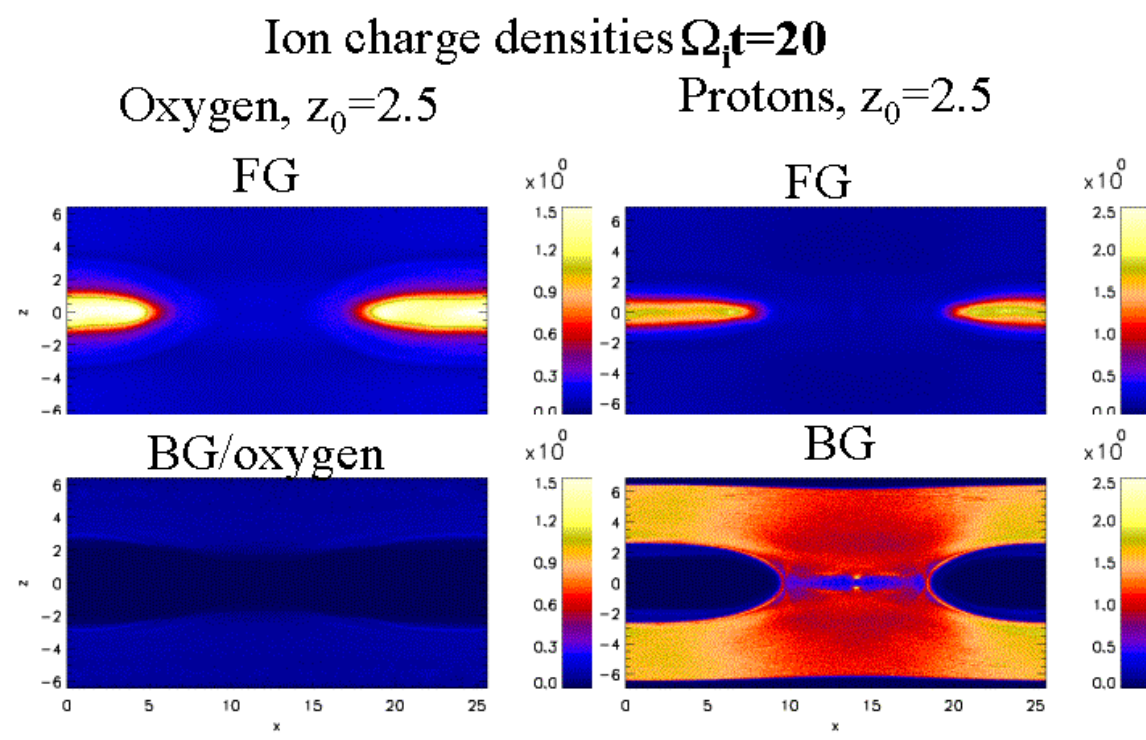
Fig. 4. Foreground (top) and background (bottom) charge densities for the same runs of Fig. 3.